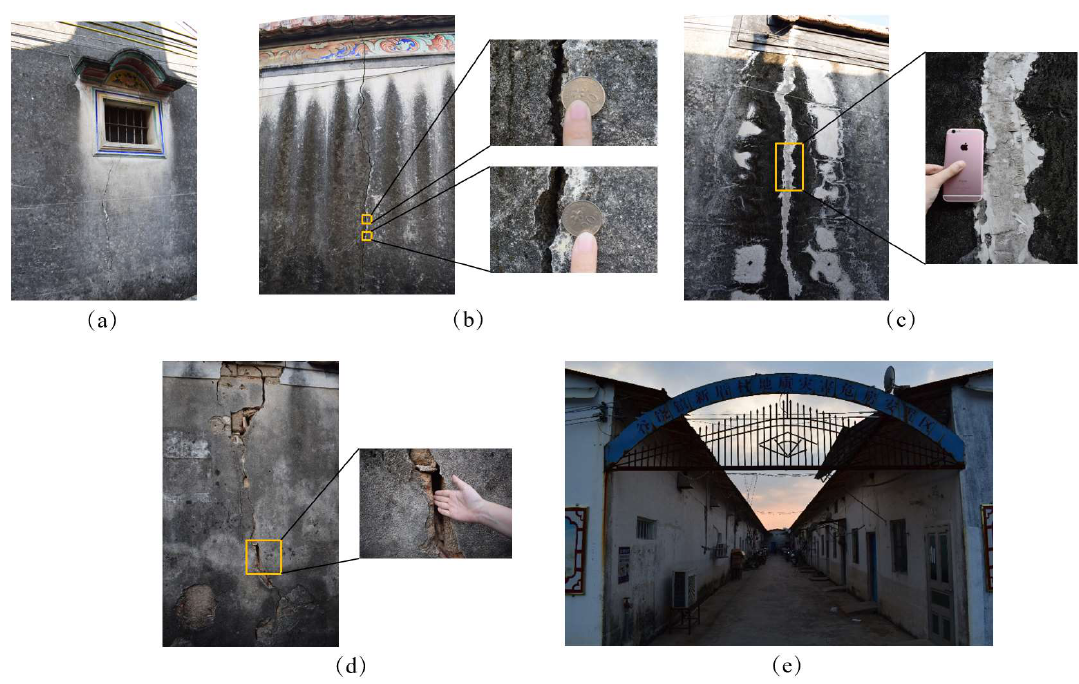
Figure 12. House destruction in ( a ) Shanbing; ( b ) Futan; ( c ) Simapu; and ( d ) Gurao. Cracks on the walls have been noticed in these Chaoshan Residences. The width of cracks varies from visible and narrow (as shown in ( a )) via coin size (as shown in ( b )) and phone size (as shown in ( c )), to very wide (as shown in ( d )). ( e ) Disaster resettlement area in Gurao.